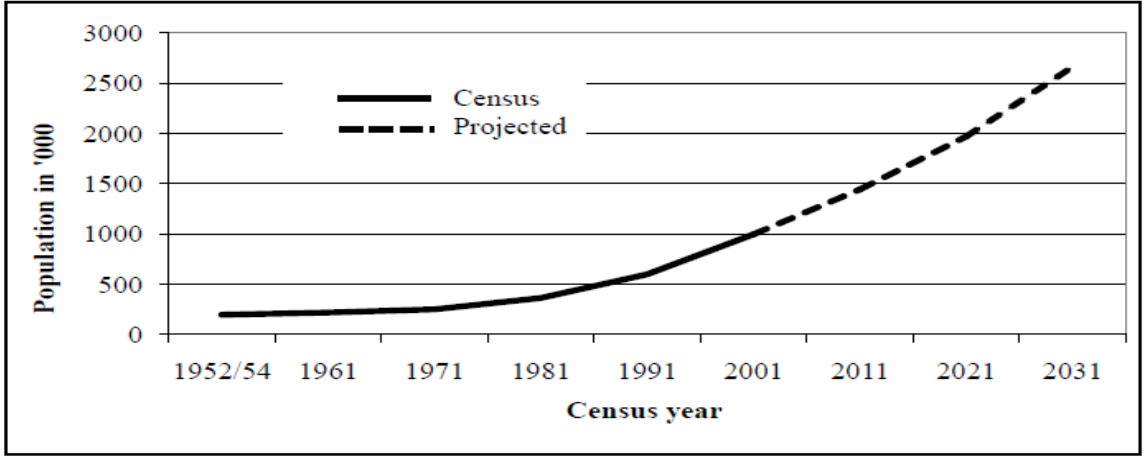
Figure 1. Urban population in Kathmandu Valley (Data source: http://www.cbs.gov.np/).